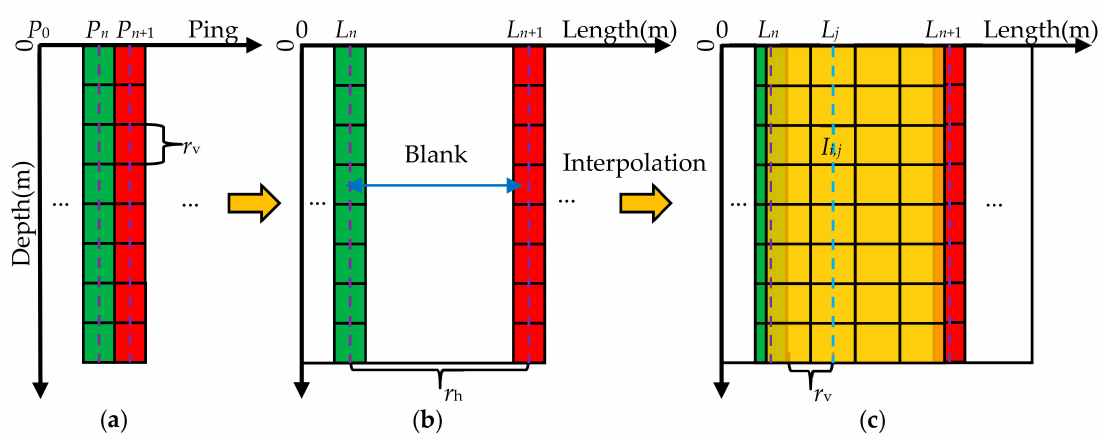
Figure 5. Interpolation process of the raw SBP waterfall image. ( a ) Select two adjacent pings in order; ( b ) calculate the actual distance of each ping relative to the first ping along the track; ( c ) calculate the corresponding image range between the two pings and perform interpolation calculation for each pixel in the range based on the average vertical resolution r v .